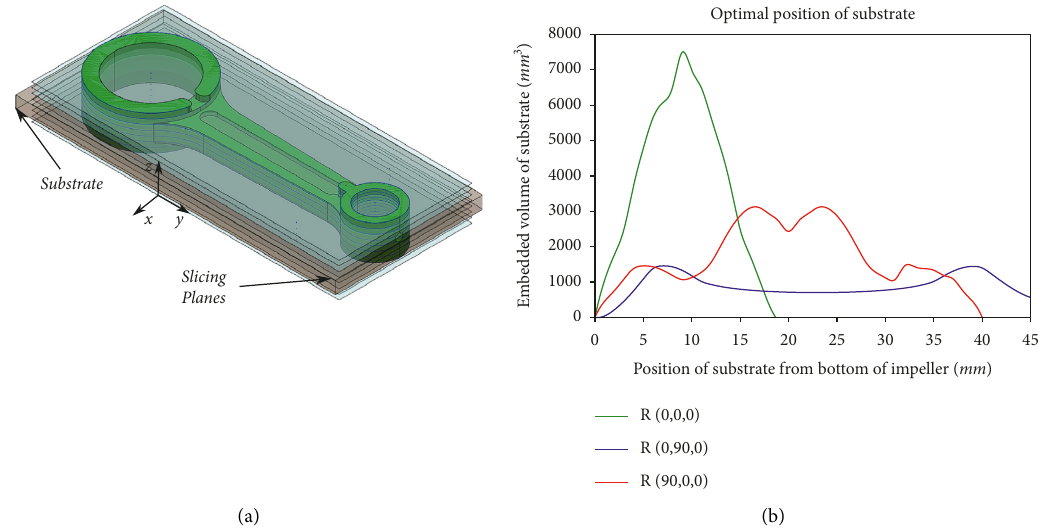
Figure 11: Illustrative example 4: (a) CAD model and (b) VI for different positions of the substrate with different